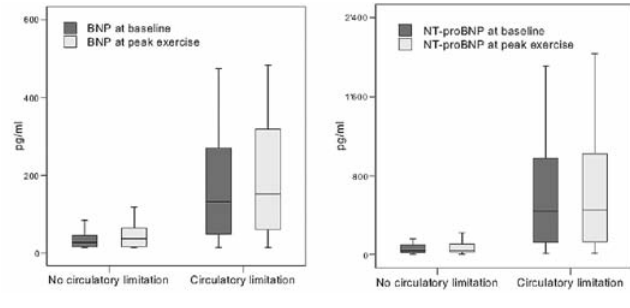
Figure: Baseline and peak exercise B-type natriuretic peptide (BNP) (left) and amino-terminal pro-brain natriuretic peptide (NT-proBNP) (right) levels in patients with and without circulatory limitation of